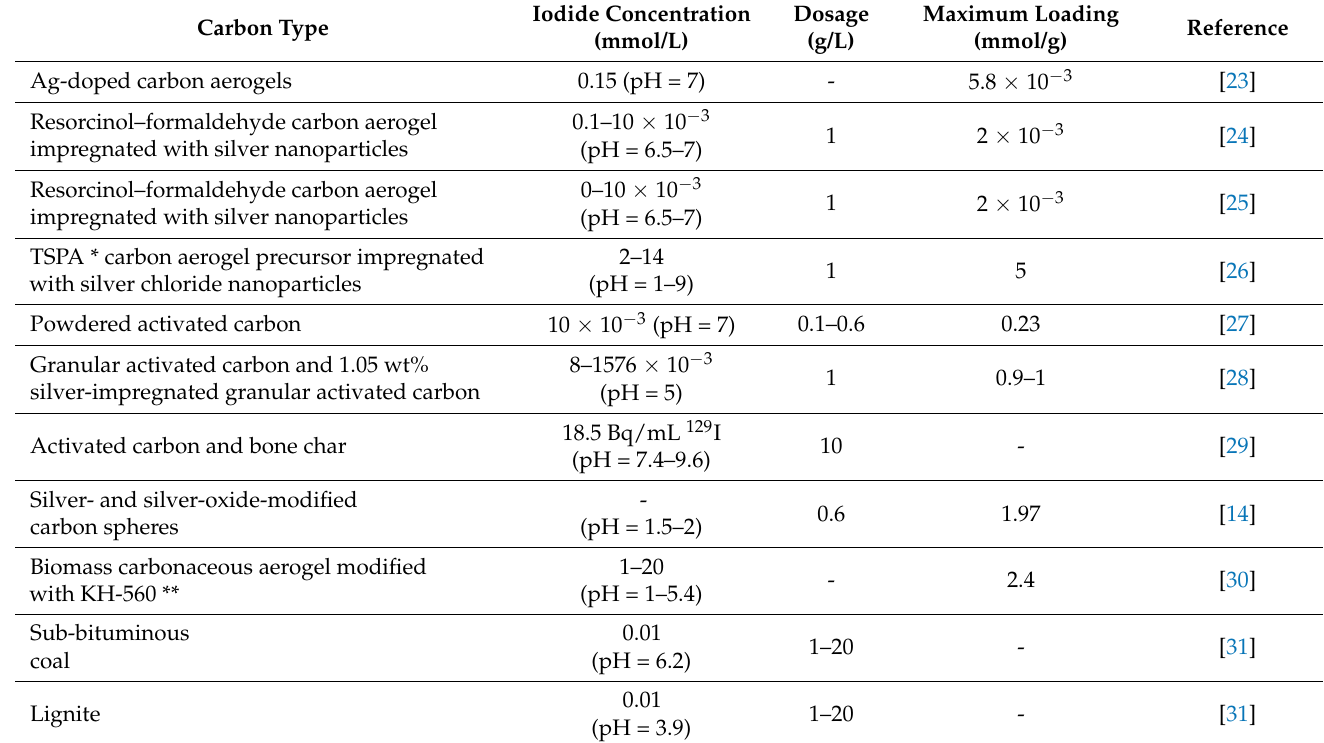
Table 1. Carbon materials used for the removal of iodide from aqueous